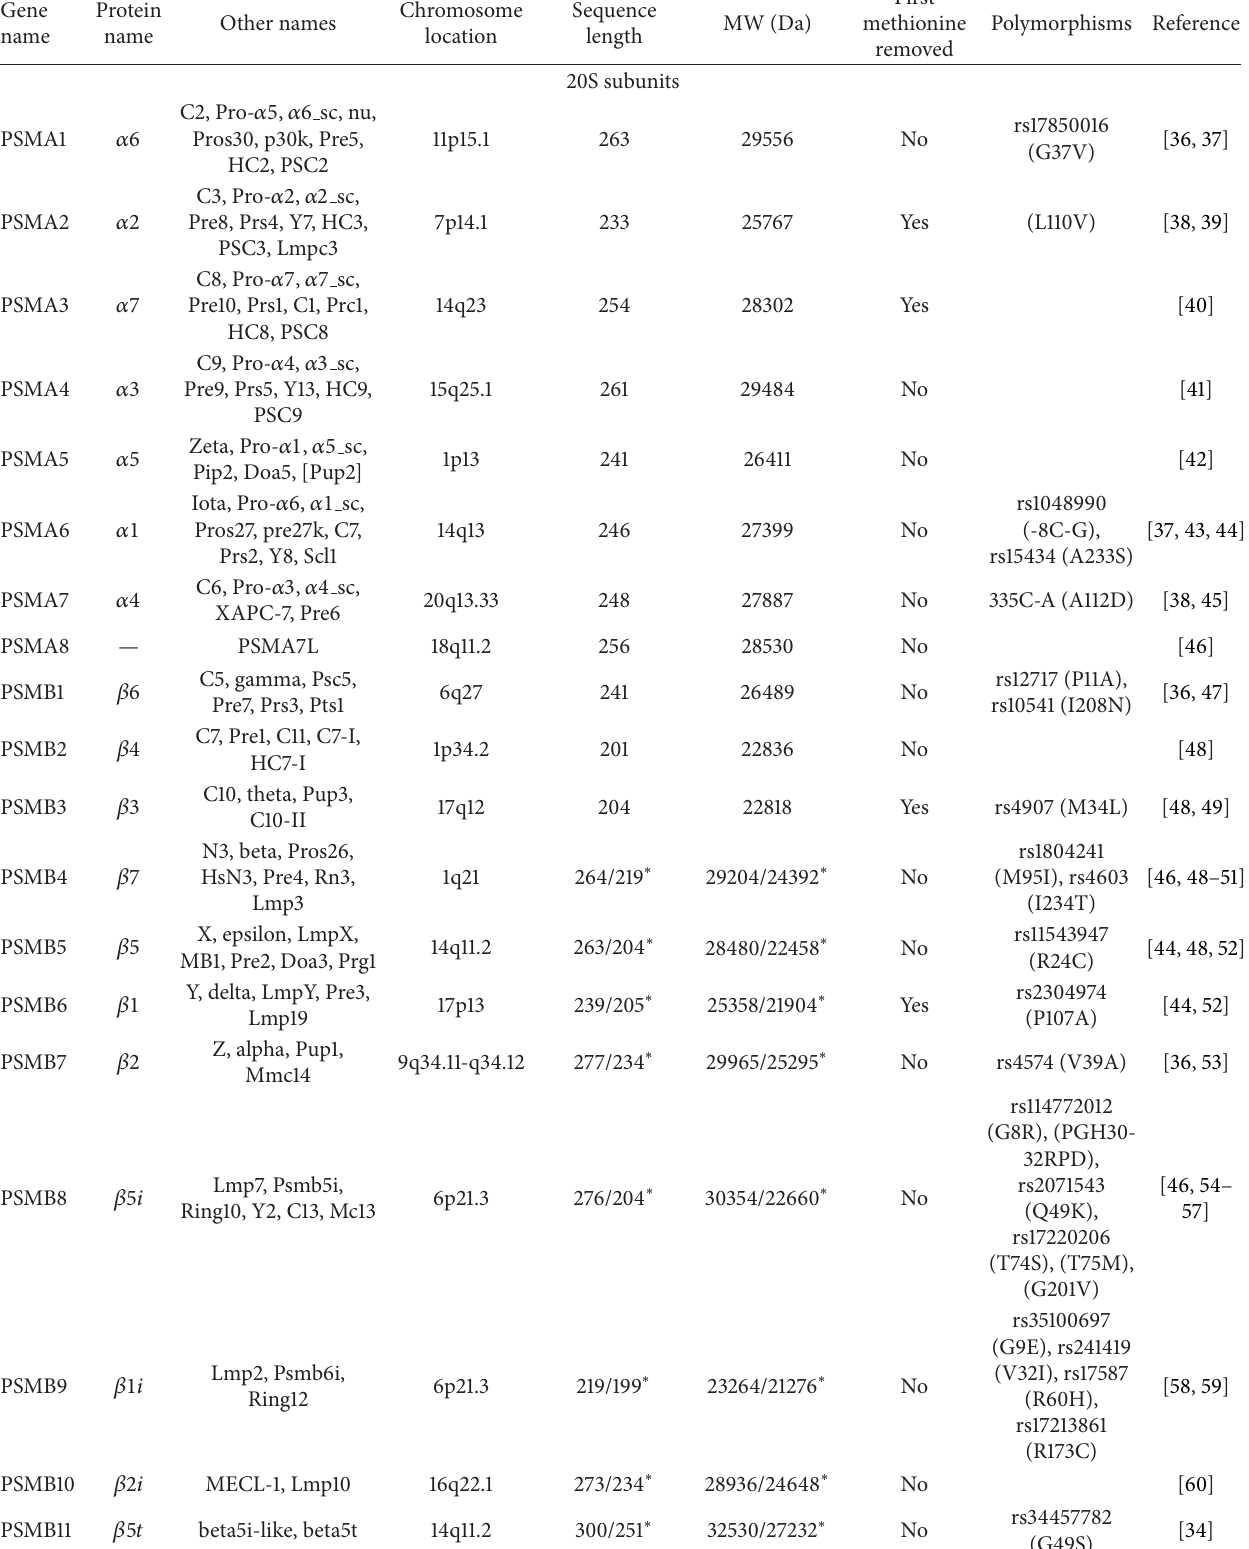
Table 1: Names and characteristics of human proteasome